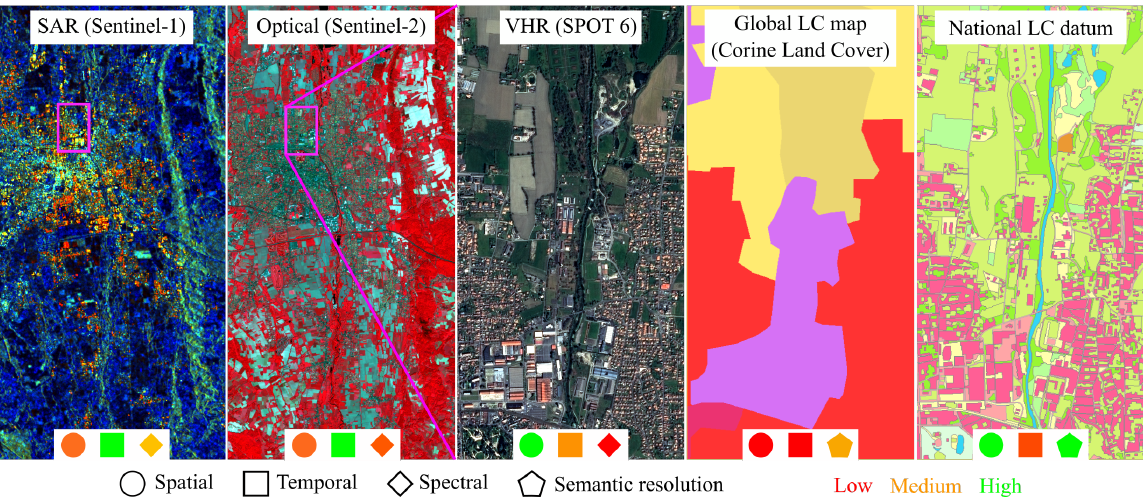
Figure 2. Main complementary data sources today for VHR land-cover mapping. The aim is to generate maps similar to a national LC datum (right) using (i) multi-modal images (time series and monoscopic VHR data) and (ii) existing imperfect geodatabases at multiple scales for the learning